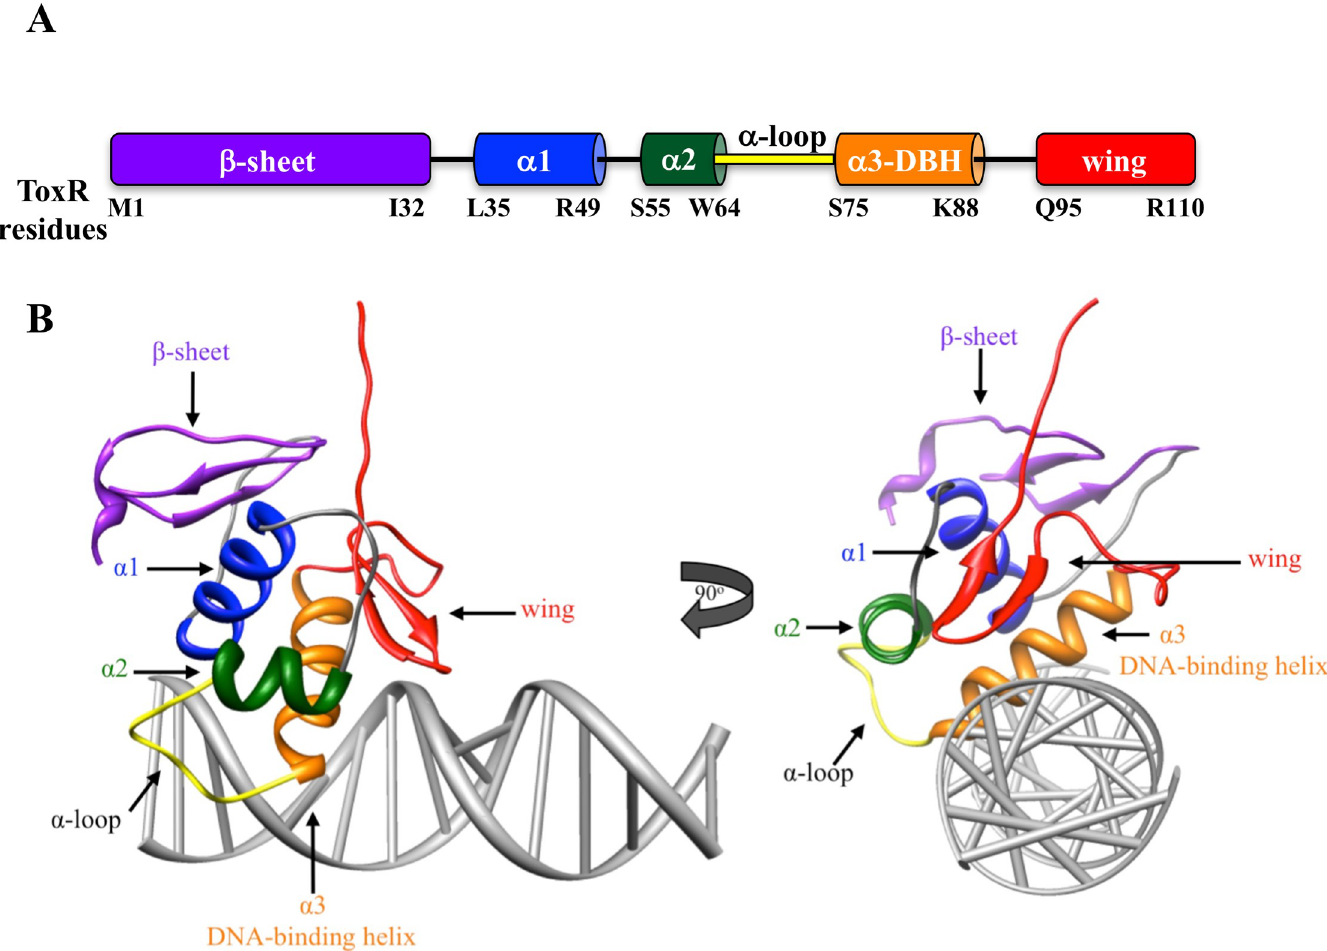
Fig 1. Domain arrangement of ToxR and modeled structure of ToxR on DNA highlighting those domains. A) Based on homology to other w-HTH proteins [7] the residues defining each domain of ToxR are highlighted. B) A modeled structure of ToxR bound to DNA was generated with the I-TASSER modeling program (http:// zhanglab.ccmb.med.umich.edu/I-TASSER/) and the crystal structure of other w-HTH family members [26]. Binding of ToxR to DNA was modeled using the NMR structure of PhoB bound to DNA [25]. Domains were highlighted with the same color scheme used in part A.